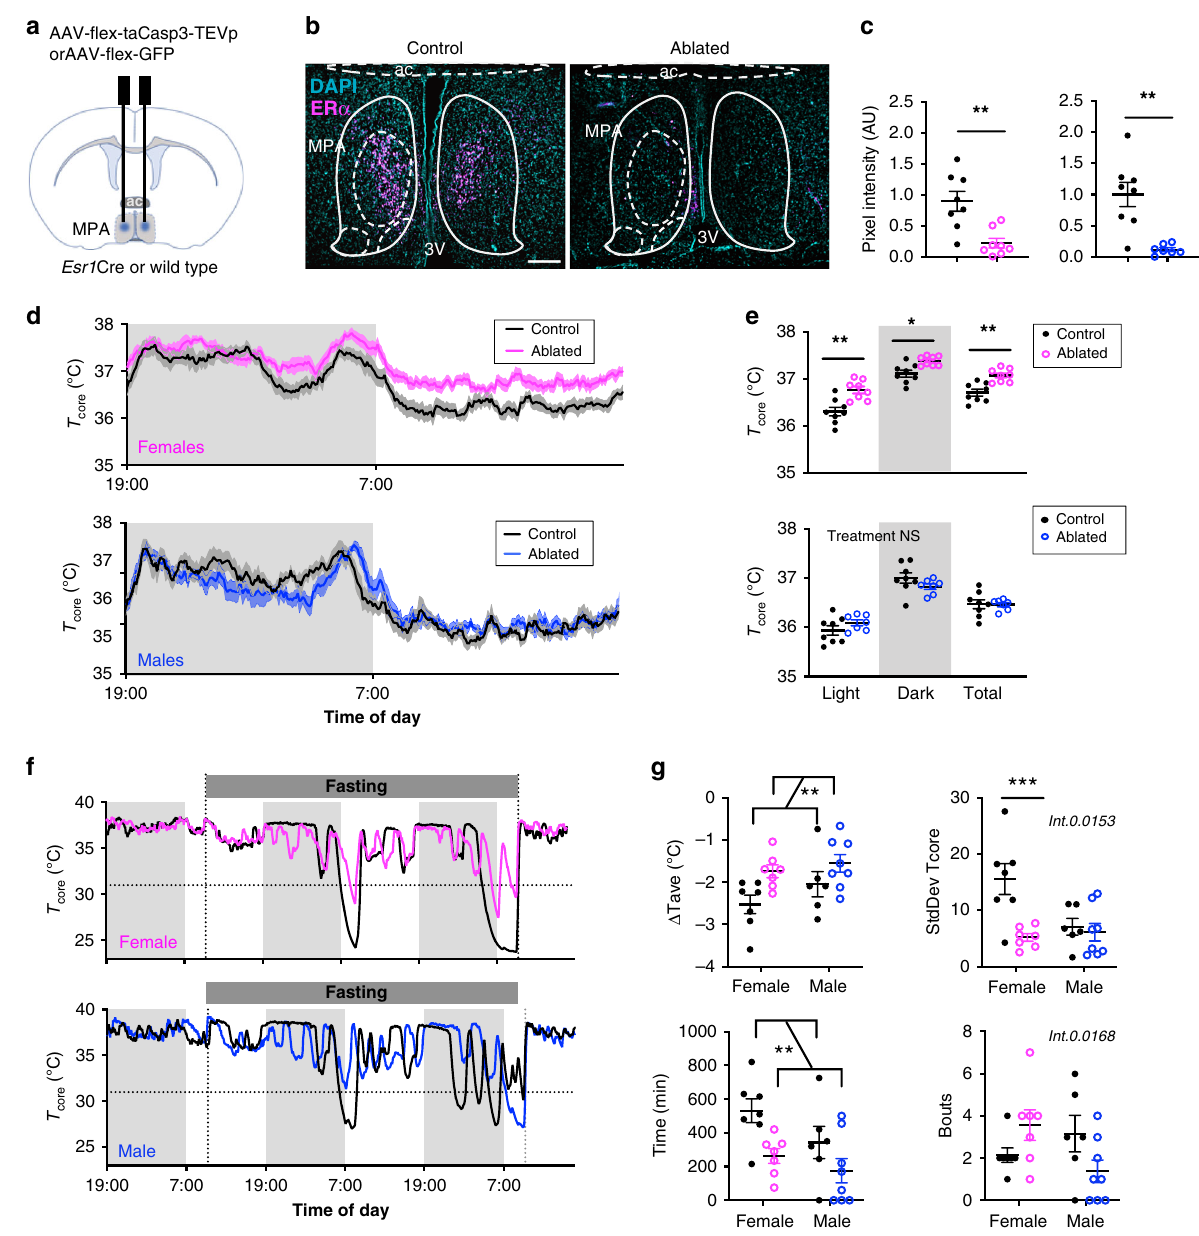
Fig. 4 ER α + cells in the MPA are required for thermoregulation and fasting-induced torpor. a Schematic showing stereotaxic delivery of AAV encoding a Cre-dependent caspase to the MPA of Esr1Cre mice to ablate Esr1 -expressing cells. b ER α immunoreactivity in the MPA of female mice following AAV- mediated ablation of Esr1 -expressing cells (right, representative of n = 8 mice) or littermate controls (left, representative of n = 8 mice). 3v third ventricle, ac anterior commissure. Scale bar: 200 µ m. c ER α immunoreactivity in the MPA of n = 8 control females (left plot, black circles), n = 8 ablated females (pink circles), n = 8 control males (right plot, black circles), and n = 7 ablated males. d Core body temperature ( T core ) over 24 h, measured every 5 min for 3 days. Group averages shown for control (black, n = 8) and ablated (pink, n = 8 female; blue, n = 7 male) mice. Shading along the curve denotes the SEM. e Average T core from mice shown in panel d highlighting per animal averages in light (7:00 to 19:00), dark (19:00 to 7:00), and total 24 h periods. f Representative T core measured every 5 min over 3 days during fasting-induced torpor in control (black) and ER α neuronal ablated (pink) female mice. Dashed line denotes T core = 31°C, the cutoff for hypothermia used here g Change in T core ( Δ T core = Lowest T core - Avg T core before the fast), variace of the T T ≤ 31°C, and number of bouts with T ≤ 31 °C during the fasting period ( n = 7 control females, 7 ablated females, 6 core , total time spent with core core control males, 8 ablated males). Statistical signi fi cance denoted by NS, not signi fi cant; * p < 0.05; ** p < 0.01; *** p < 0.001 for two tailed t-tests c , Sidak ’ s multiple comparison tests e , g following a signi fi cant effect of treatment, time or sex or interactions in a two-way (RM) ANOVA. All error bars show